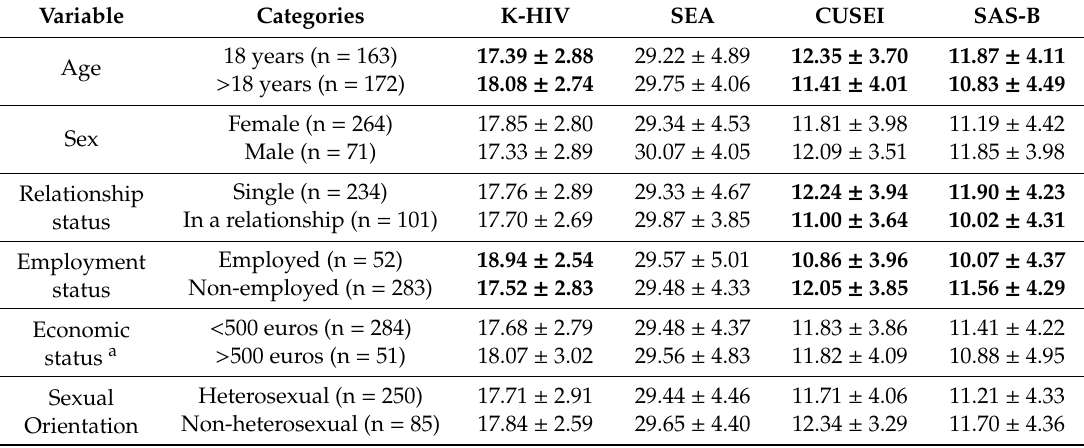
Table 3. Di ff erences in risk of HIV infection between participants based on personal